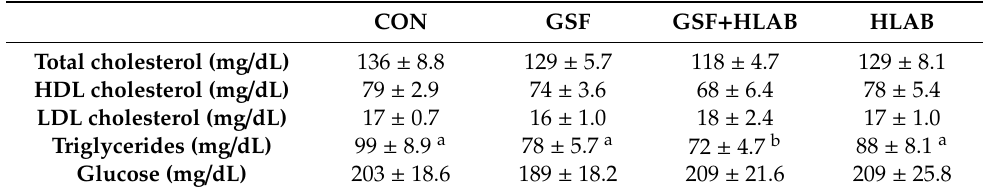
Figure 1. Effect of 2.5% wine grape seed flour (GSF) and heat-killed kefir lactic acid bacteria (HLAB) on C57BL/6J mice fed a high-fat and high-fructose diet (HFFrD) containing 5% microcrystalline cellulose (CON), 2.5% wine grape seed flour (GSF), 2.5% GSF with orally administered heat-killed kefir lactic acid bacteria (GSF+HLAB), and orally administered heat-killed kefir LAB (HLAB) for 8 weeks. ( A ) Body weight gain, ( B ) total energy intake, ( C ) adipose tissue weight, ( D ) Hematoxylin and Eosin (H&E) staining of adipose tissue. Data are expressed as mean ± SE; n = 8–10/group. Values not sharing a common letter differed significantly at p < 0.05. Table 3. Metabolic parameters in HFFr diet-induced obese (DIO) mice fed 5% microcrystalline cellulose (CON, control), 2.5% wine grape seed flour (GSF), 2.5% GSF with heat-treated LAB (GSF+HLAB), and heat-treated LAB (HLAB) for 8 weeks.